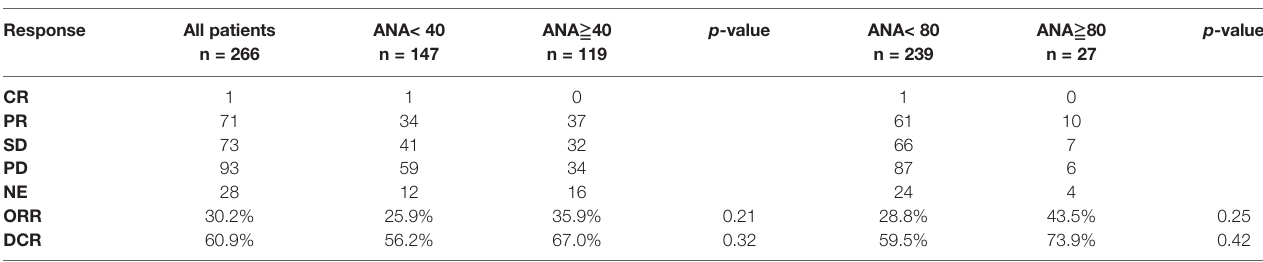
TABLE 2 | Response rate of the ICI treatment according to ANA